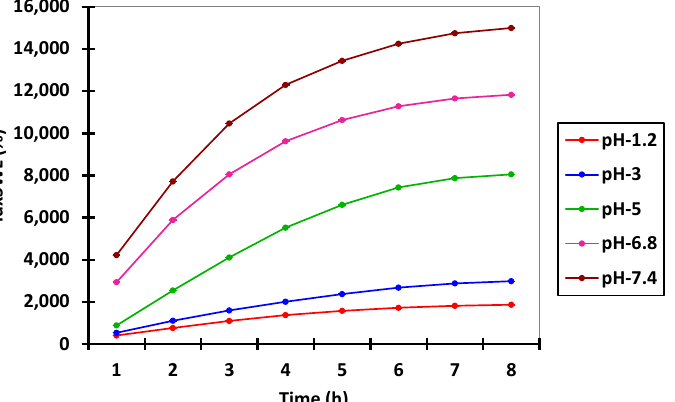
Figure 5. Interval plots of the swelling index (idxSWL (%)) of microspheres for pH * Time interaction factor levels.